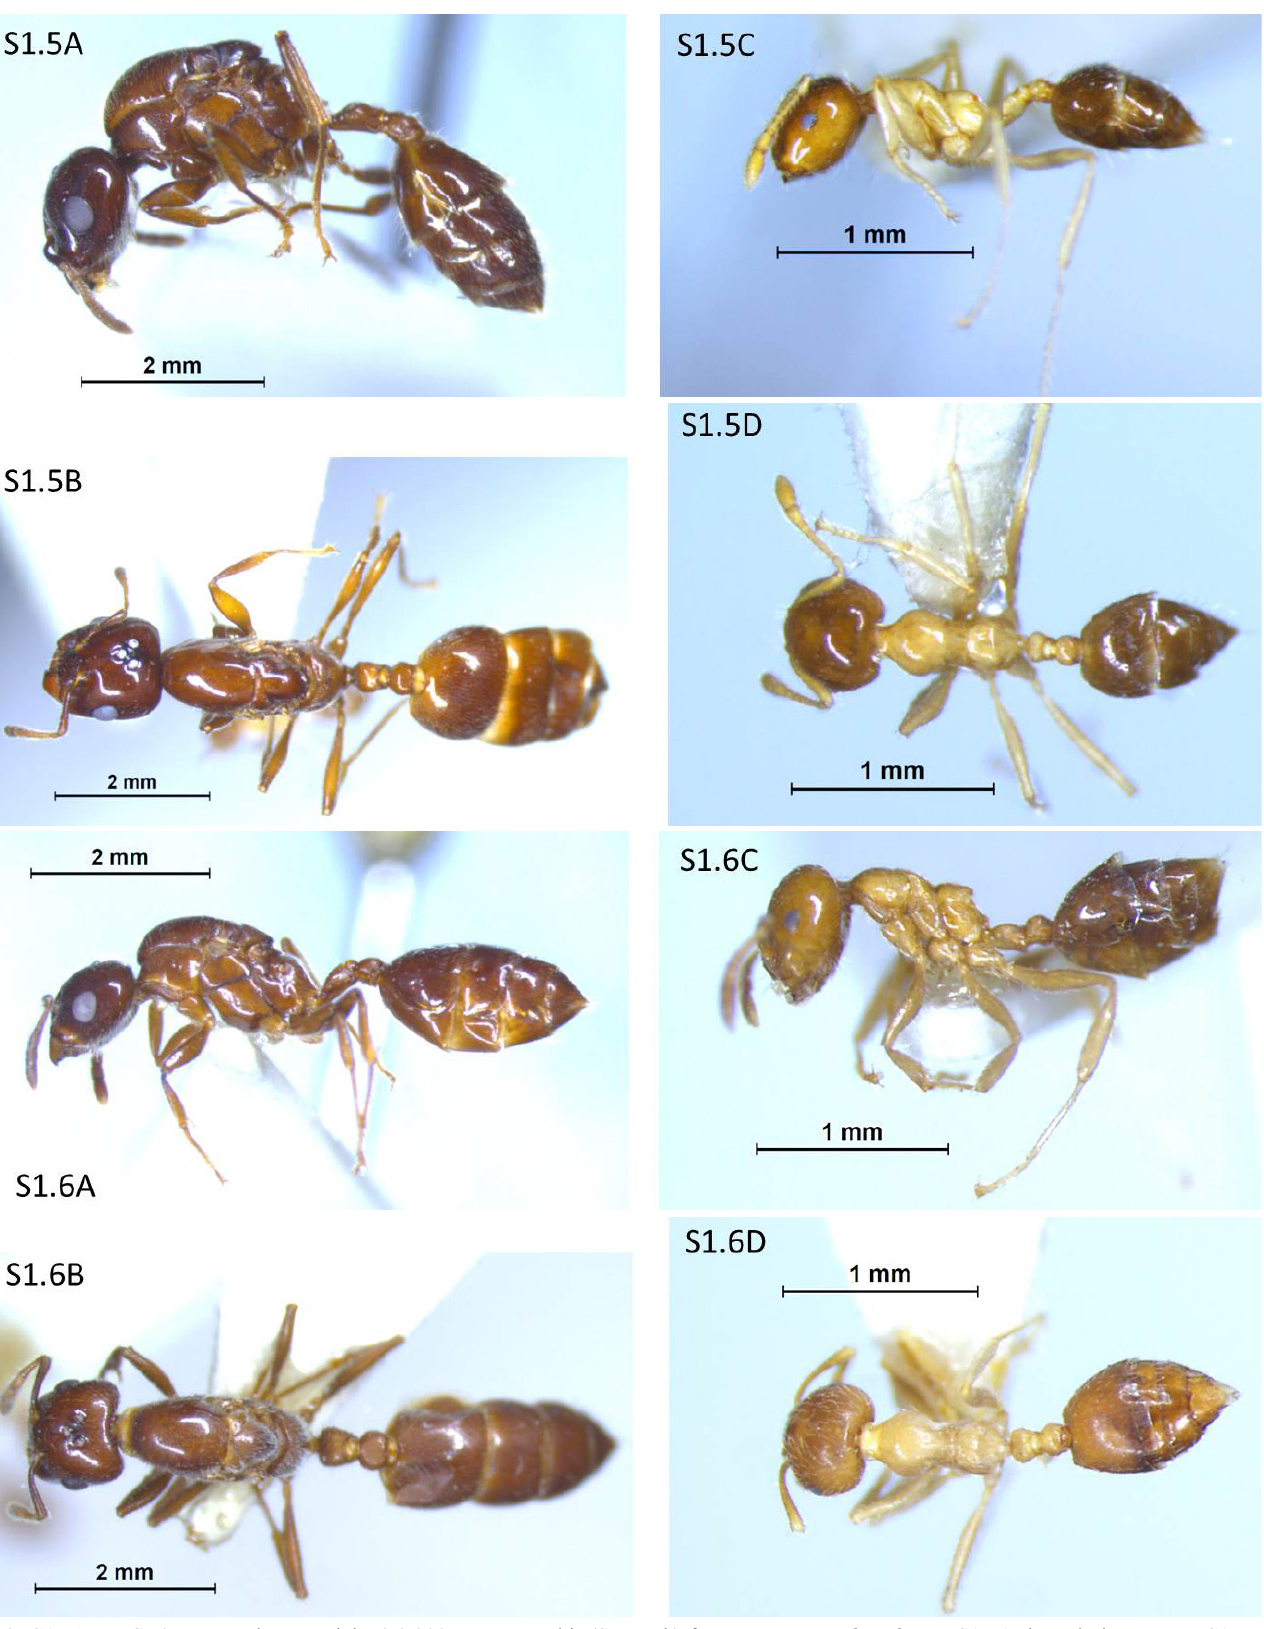
Fig S1.5A-D: C. decamera, leg. B. Fiala, 2.9.2007, near Lambir (Sarawak) from Macaranga hypoleuca; S1.5A: lateral view queen, S1.5B dorsal view queen, S1.5C lateral view worker, S1.5D dorsal view worker. Fig S1.6A-D: C. maryatii, leg. H. Feldhaar, 3.10.2002, Kampung Madai (Sabah) from Macaranga motleyana; S1.6A: lateral view queen, S1.6B dorsal view queen, S1.6C lateral view worker, S1.6D dorsal view